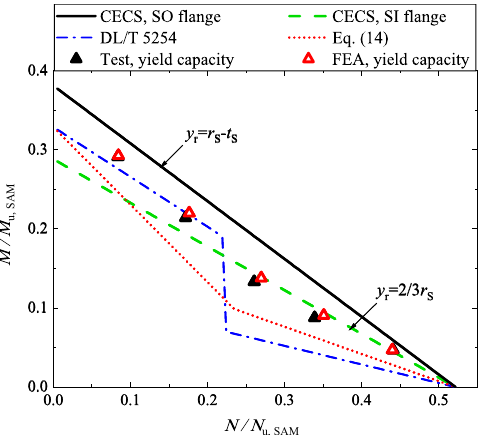
Figure 19. Interaction of bending capacity with tensile capacity.